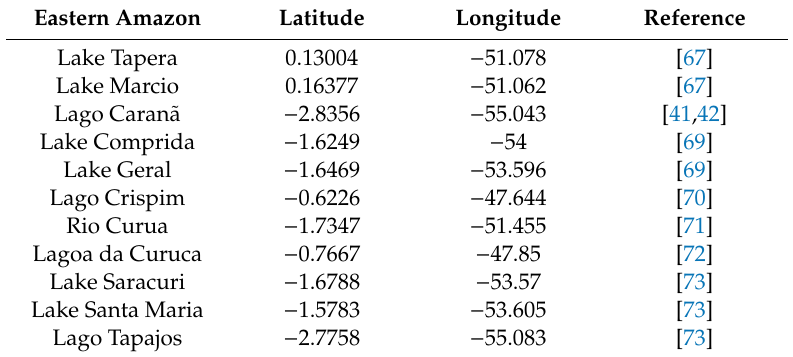
Table 1. Compiled charcoal records used for the regional charcoal curve (RCC) from the eastern Amazon. Records were compiled from the Global Charcoal Database (GCD)